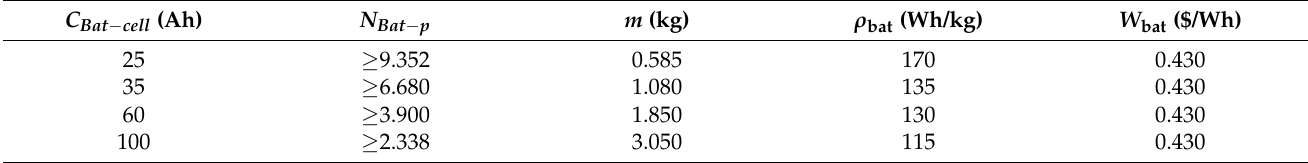
Table 4. The parallel range under different batteries’ capacities.